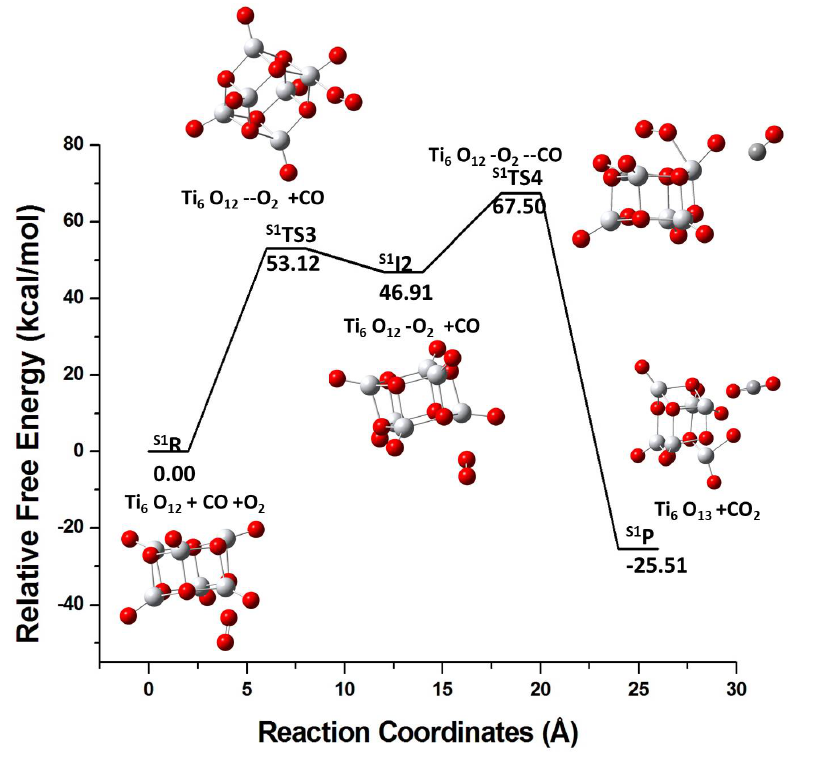
Figure 7. Energy profile for the reaction of the S1 isomer with O 2 followed by the reaction with the CO molecule. R, S 1 TS3, S 1 I2, S 1 TS4, and S 1 P represents reactants, transition state 3, intermediate state, transition state 4, and product, respectively.